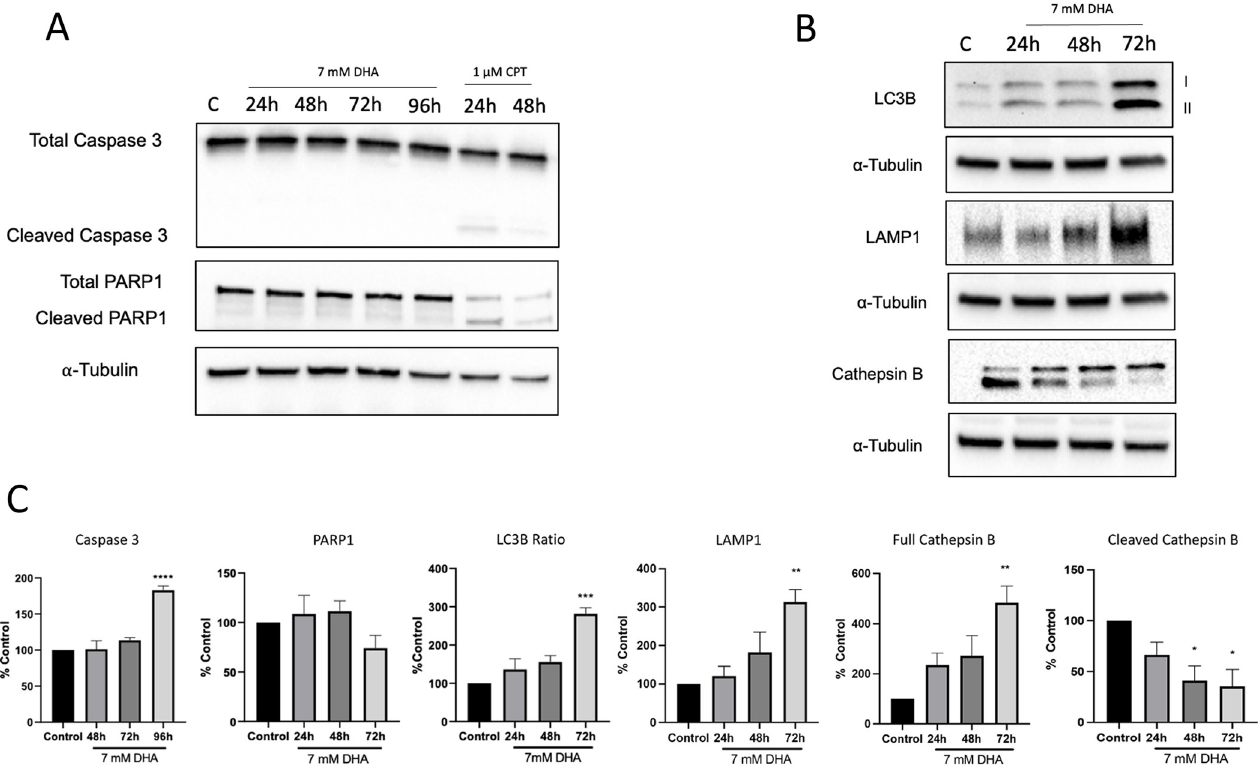
Fig 4. Cell death markers were evaluated in 7 mM DHA-exposed HepG3 cells. (A) Caspase 3 and PARP-1 proteins were probed in cells dosed with 7 mM DHA from 24 to 96 h exposure and CPT 1uM for 24 h and 48 h. A cleaved band for caspase 3 and PARP1 is present in cells dosed with CPT. CPT serves as a positive apoptotic control. Immunoblotting of samples dosed with CPT was performed in one biological repeat. (B) LC3B, LAMP-1, and cathepsin B levels at 24, 48, and 72 h. (C) Quantification of expression levels changes in cell death markers. The level of statistical significance was marked as follows: � p < 0.05; �� p < 0.01; ��� p <